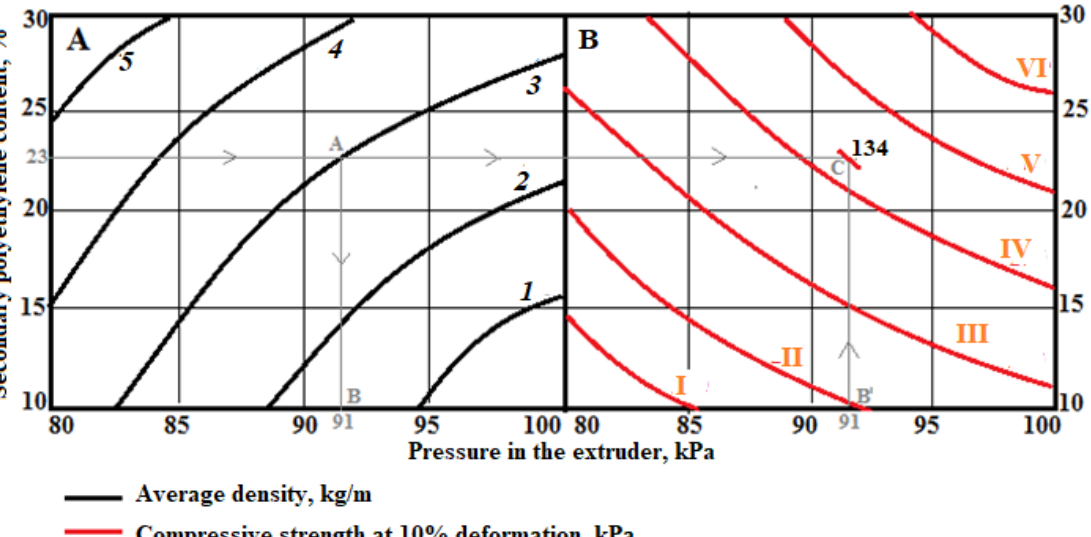
Figure 6. Nomogram for determining the consumption of recycled polyethylene. Average density values, kg/m 3 : 1–20; 2–22; 3–24; 4–26; 5–28. Values of compressive strength, kPa: I-100; II-110; III-120; IV-130; V-140; VI-150.